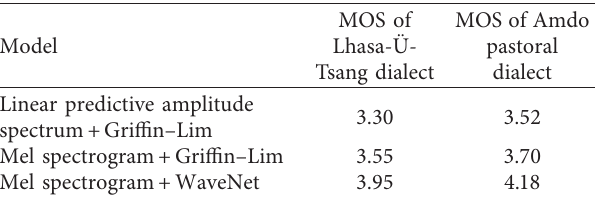
Table 4: The MOS comparison of speech synthesized by different